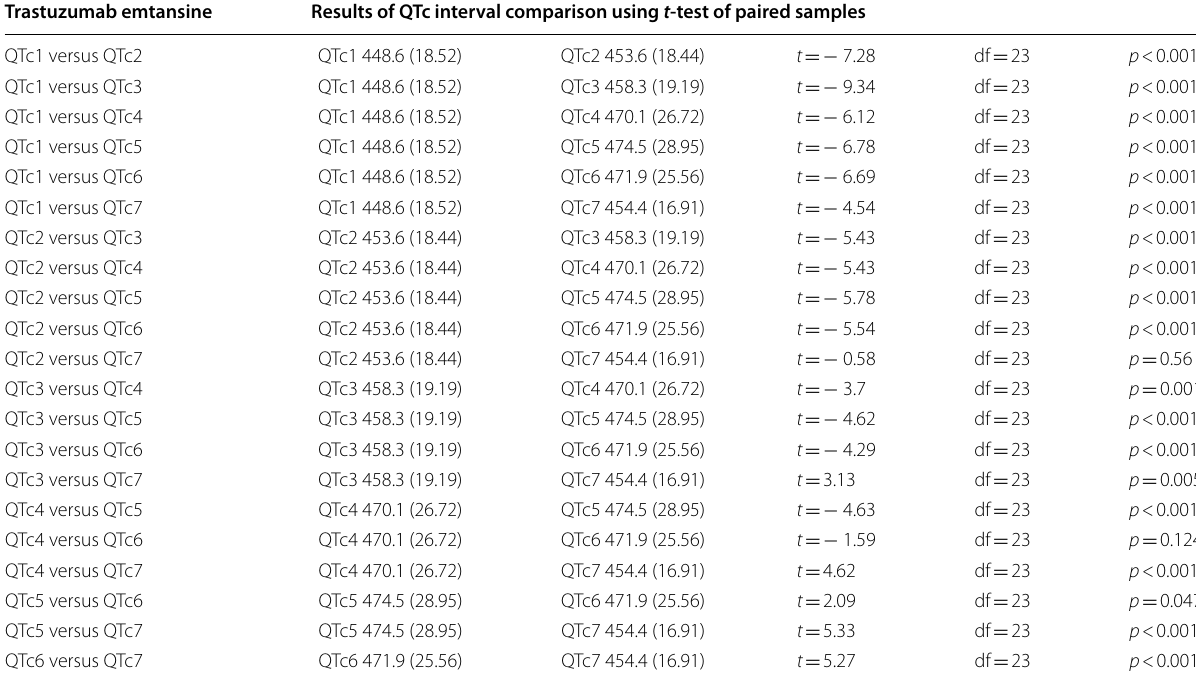
Student’s t -test of paired samples was also used to compare QTc interval values obtained before each trastuzumab emtansine cycle and after the last application of the drug. A statistically significant p value of < 0.05 was used